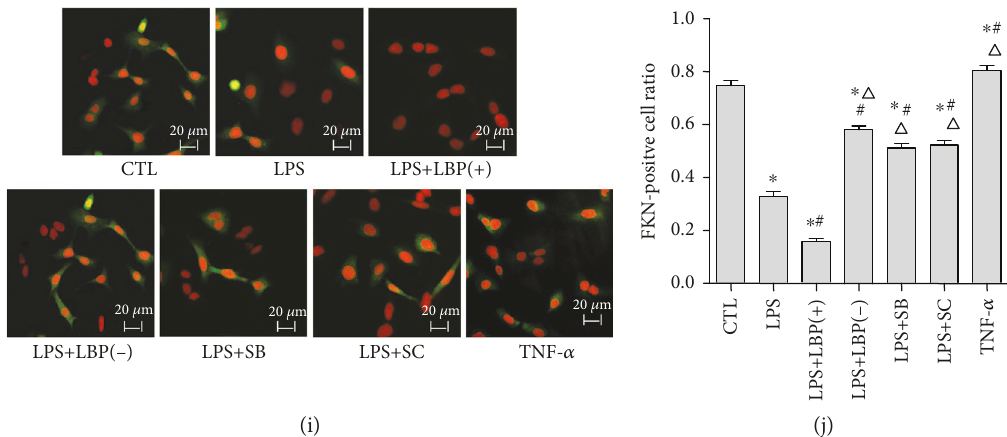
Figure 1: LBP gene overexpression further decreased LPS-induced downregulation of FKN mRNA and protein expression; LBP gene silencing, SB203580, and SC-514 suppressed LPS-induced downregulation of FKN mRNA and protein expression, respectively, in A549 cells. RT-PCR and ELISA were used to analyze the LBP and FKN mRNA and protein expression, respectively, in A549 cells. The LBP mRNA expression is shown in (a). The relative LBP mRNA levels (normalized to GAPDH mRNA) in LPS-stimulated cells are signi fi cantly higher than those in control cells ( p < 0 05 ). The LBP mRNA levels of the LBP(+) group and LBP( − ) group are upregulated and downregulated, respectively, when compared with the control group ( p < 0 05 in all cases). The LBP mRNA levels of the LPS+LBP(+) group of cells are upregulated compared with those of the control group and LPS group ( p < 0 05 in all cases). The LBP mRNA levels of the LPS+LBP( − ) group of cells are upregulated compared with those of the control group and downregulated compared with those of the LPS group ( p < 0 05 in all cases). The LBP mRNA level of the empty vector group is not di ff erent from that of the control group ( p > 0 05 ). The FKN mRNA expression is shown in (e). The relative FKN mRNA levels (normalized to GAPDH mRNA) in LPS-stimulated cells are signi fi cantly lower than those in control cells ( p < 0 05 ). The FKN mRNA levels of the LPS+LBP(+) group of cells are downregulated compared with those of the control group and the LPS group ( p < 0 05 in all cases). The FKN mRNA levels of the LPS+LBP( − ), LPS+SB, and LPS+SC groups of cells are downregulated compared with those of the control group and upregulated compared with those of the LPS group ( p < 0 05 in all cases). The FKN mRNA levels of the TNF- α group are upregulated compared with those of the control group ( p < 0 05 ). The results of ELISA and western blotting in (b), (c), and (d) demonstrate that the LPS treatment signi fi cantly increases the levels of LBP protein expression ( p < 0 05 ). The LBP protein levels of the LBP(+) group and LBP( − ) group are upregulated and downregulated, respectively, compared with those of the control group ( p < 0 05 in all cases). The LBP protein levels of the LPS+LBP group of cells are upregulated compared with those of the control group and the LPS group ( p < 0 05 in all cases). The LBP protein levels of the LPS+LBP( − ) group of cells are upregulated compared with those of the control group and downregulated compared with those of the LPS group ( p < 0 05 in all cases). ELISA and western blotting assay in (f), (g), and (h) demonstrate that the LPS treatment signi fi cantly reduces the levels of FKN protein expression ( p < 0 05 ). The FKN protein levels of the LPS+LBP group of cells are downregulated compared with those of the control group and the LPS group ( p < 0 05 in all cases). The FKN protein levels of the LPS+LBP( − ), LPS+SB, and LPS+SC groups of cells are downregulated compared with those of the control group and upregulated compared with those of the LPS group ( p < 0 05 in all cases). The FKN protein levels of the TNF- α group are higher than those of the control group ( p < 0 05 ). Immuno fl uorescence staining results in (i) and (j) con fi rmed that TNF- α induced a high FKN-positive cell ratio in A549 cells. LPS decreased FKN-positive cell ratio in A549 cells; LBP gene overexpression further decreased FKN-positive cell ratio which was inhibited by LPS, LBP gene silencing, and SB203580. Also, SC-514 reduced the inhibition of LPS ( p < 0 05 in all cases). The photomicrographs are 200x magni fi cation. Data are presented as means ± SD of six independent experiments ( n = 6 ). ∗ represents p < 0 05 when compared with that in the CTL; # represents p < 0 05 when compared with that in the LPS; △ represents p < 0 05 when compared with that in the LPS+LBP(+). ∗ p < 0 05 when compared with that in the control group; ◇ represents p < 0 05 when compared with that in the LPS+LBP( − ) group; △ represents p < 0 05 when compared with that in the